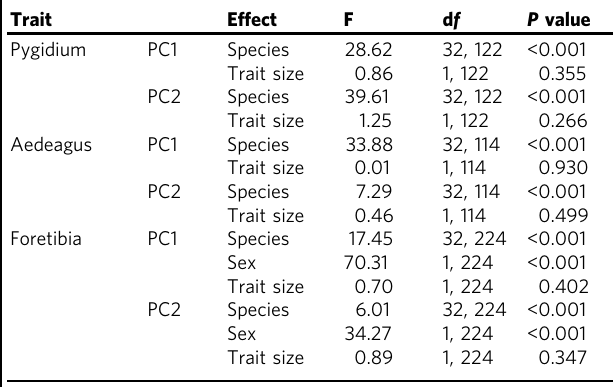
Table 1 The effect of species and trait size on trait shape